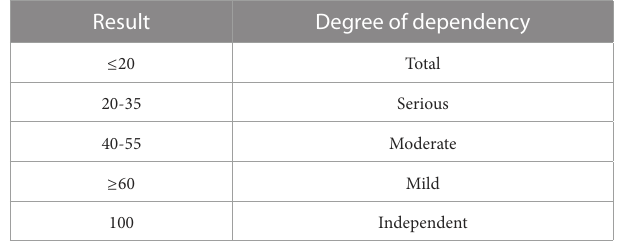
TABLE2 Degreesofdependencyaccordingtotheobtainedresultsapplying theBarthelIndex.